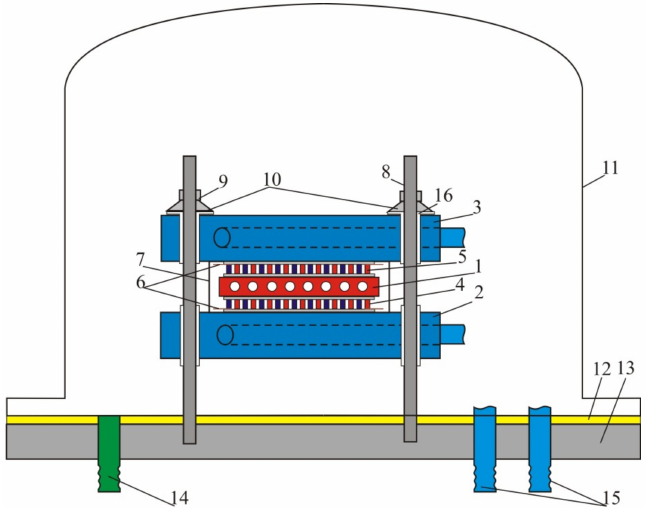
Figure 4. Schema of measurement unit of output characteristics of generator TE unicouples and TE modules over 100–600 ◦ C temperature range; 1—copper electric heater with thermocouple. 2, 3—copper water radiator with thermocouple. 4, 5—upper and lower TE modules (TE unicouples).